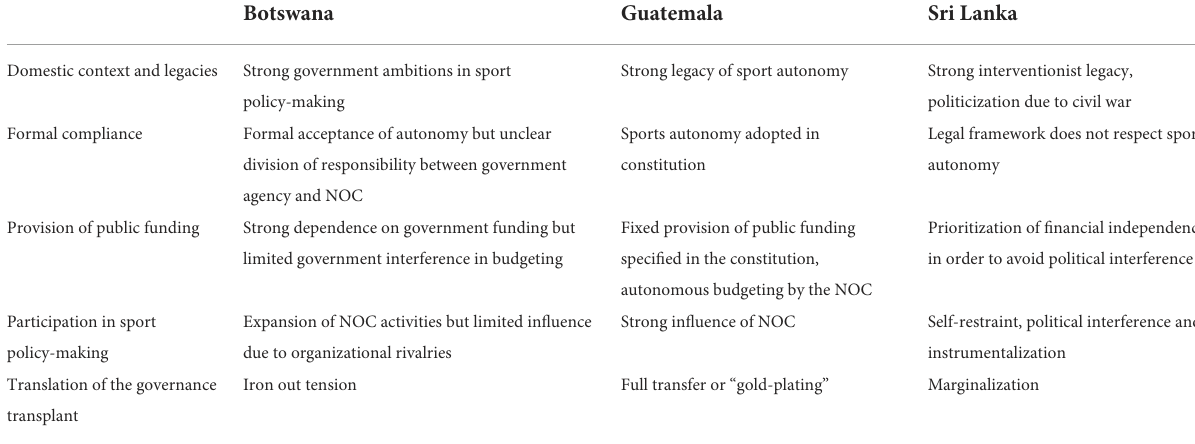
TABLE 4 The autonomy of the National Olympic